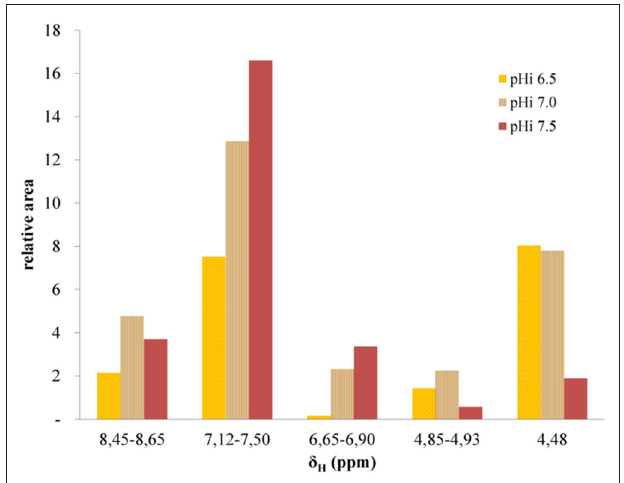
FIGURE 7 | Relative areas of 1 H NMR signals for the indicated δ H ranges for melanoidins obtained from DL prepared at different pH i values. The area of the aliphatic spectral region ( δ H 0.5–2.5) was used as an internal reference.